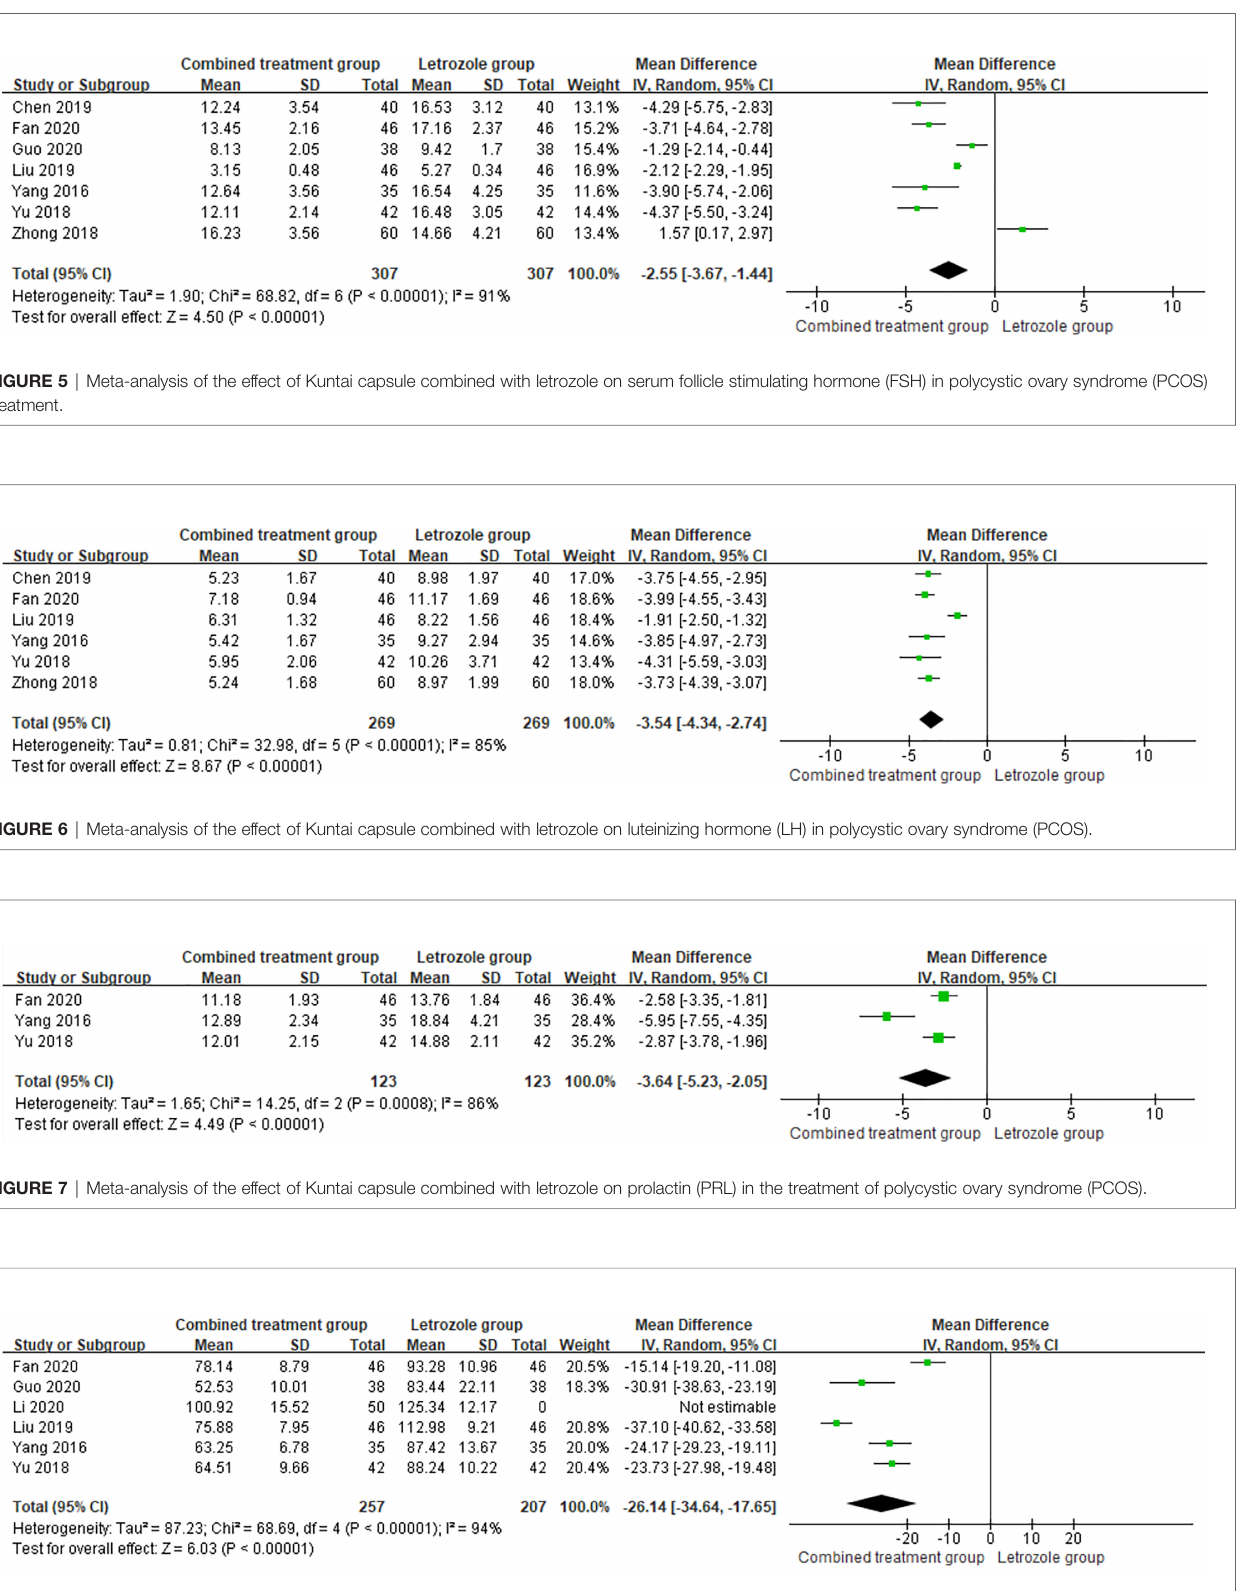
Frontiers in Endocrinology |